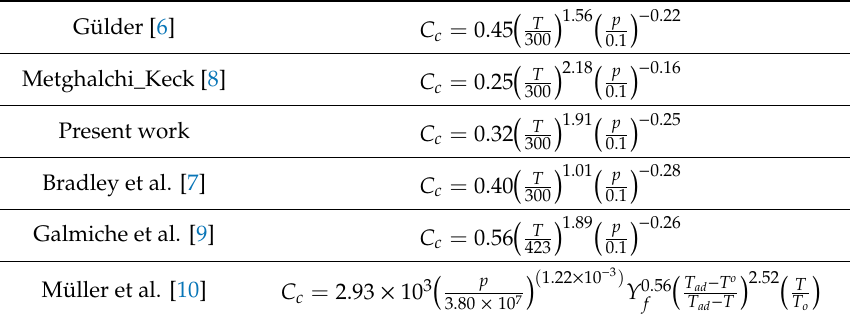
Table 1. Correlations for the burning velocity of stoichiometric iso-octane. Gülder [6]